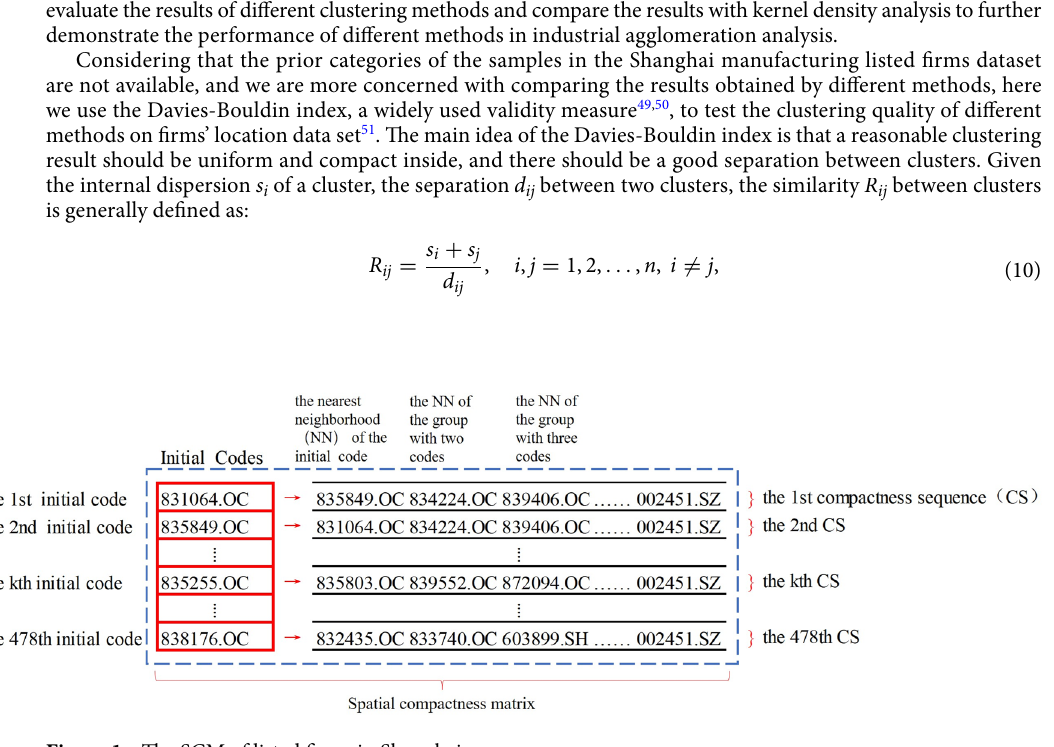
Figure 1. The SCM of listed firms in